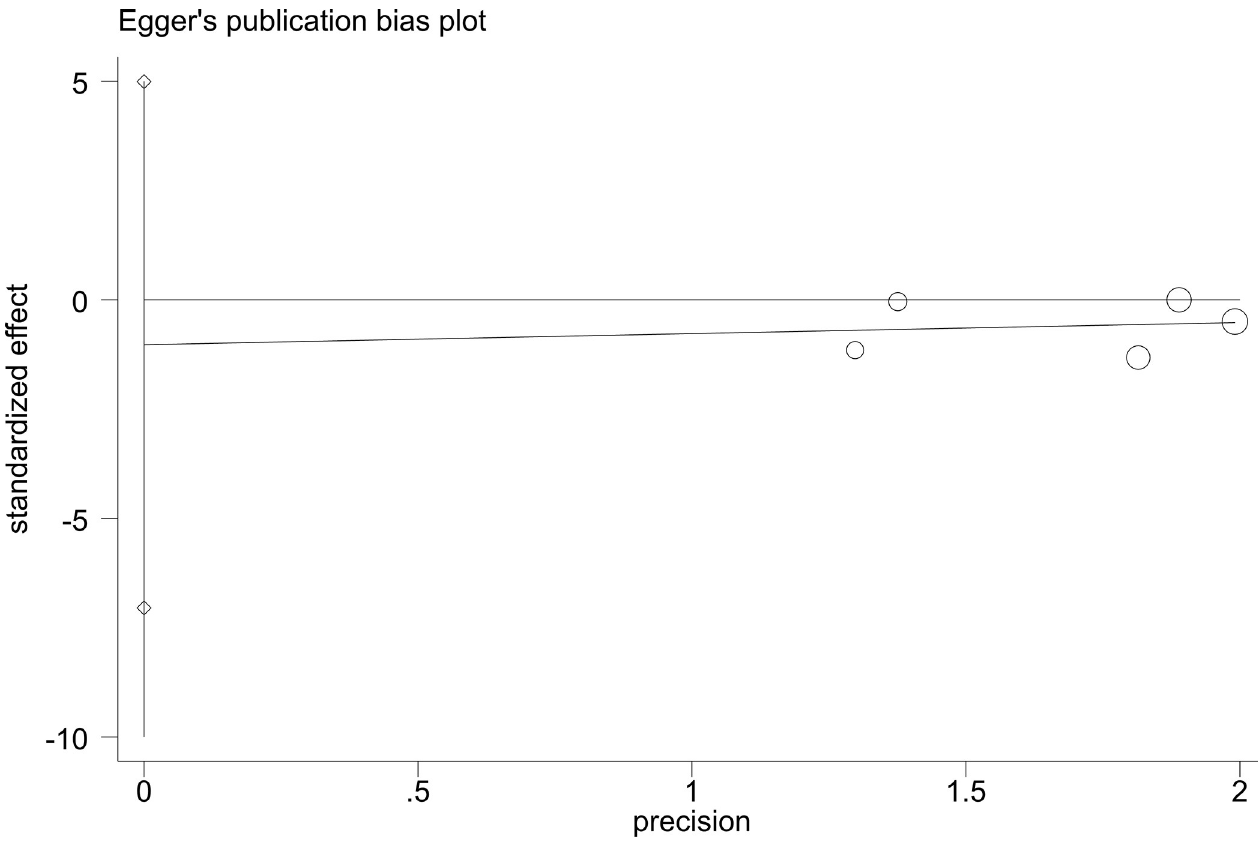
Fig 7. Egger’s test for DCP